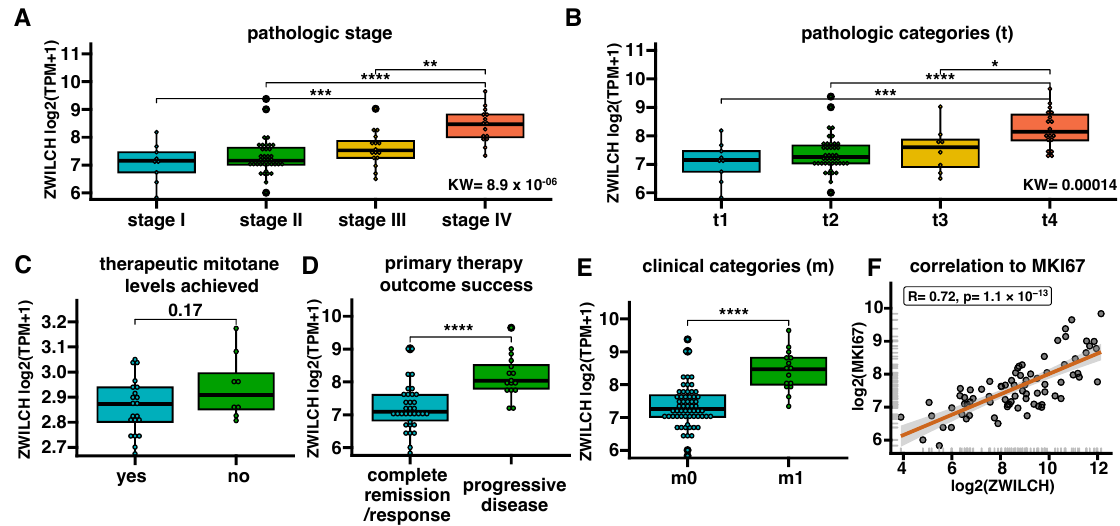
Figure 2. ZWILCH gene expression in ACC patients (data from TCGA) according to selected clinical characteristics of tumor progression ( A – E ). The bar plot presents the median with IQR range. Each dot represents ZWILCH expression in individual patients. Statistical differences in ZWILCH gene expression for comparisons with more than two categories were evaluated using the Kruskal–Wallis test followed by the Dunn post hoc test. For comparisons with two categories, statistical differences were determined by the Mann–Whitney U test. Correlation of ZWILCH and KI67 expression in ACC patients ( F ). Differences between groups marked with asterisks: * p < 0.05, ** p < 0.01, *** p < 0.001, **** p < 0.0001. The graph presents the logarithmic values of TPM+1 for ZWILCH and MKI67 genes. The regression line demonstrates a strong positive correlation ( p = 1.1 × 10 − 13 , R = 0.72). Each dot represents data from individual patients.